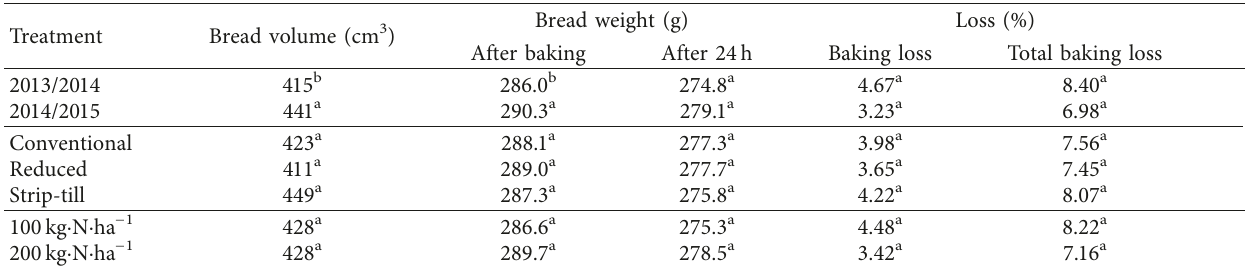
Conventional Reduced Strip-till